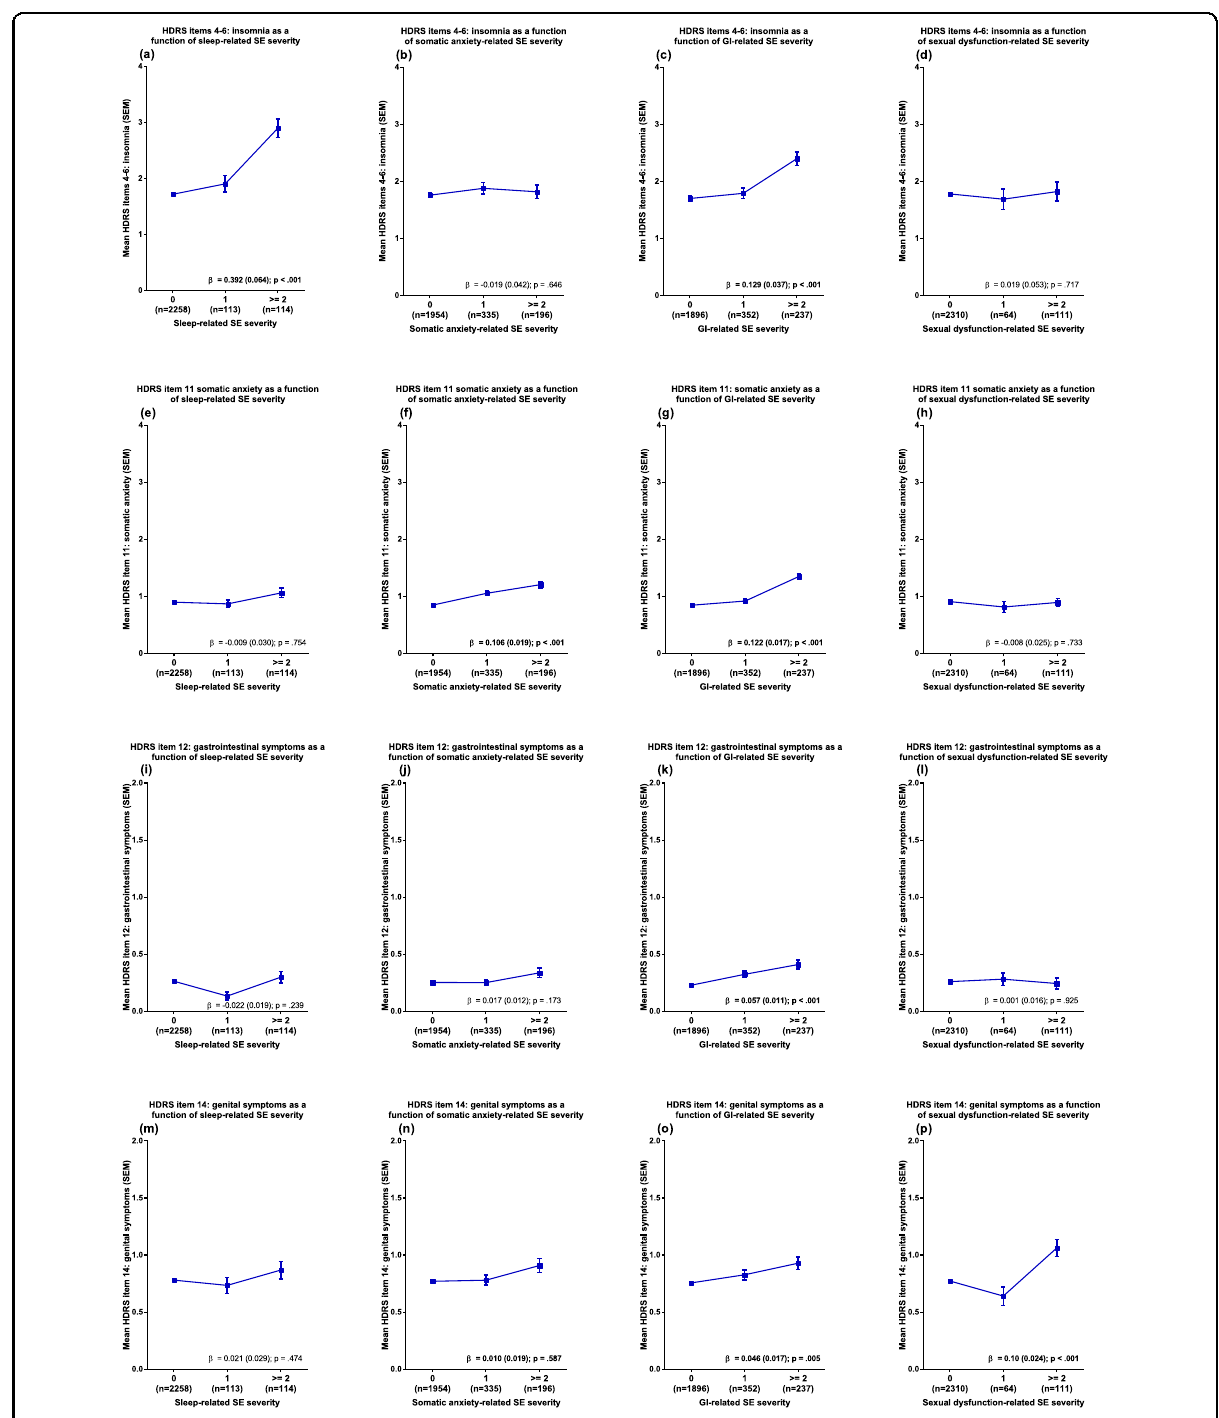
Fig. 1 Endpoint HDRS-17 item ratings as a function of individual side effect (SE) group severity. Side effect severities present in ≤ 50 patients have been collapsed for easier visualisation. β Beta coef fi cient (SEM) for the speci fi c SE-group predictor, GI gastrointestinal function, SEM standard error of the